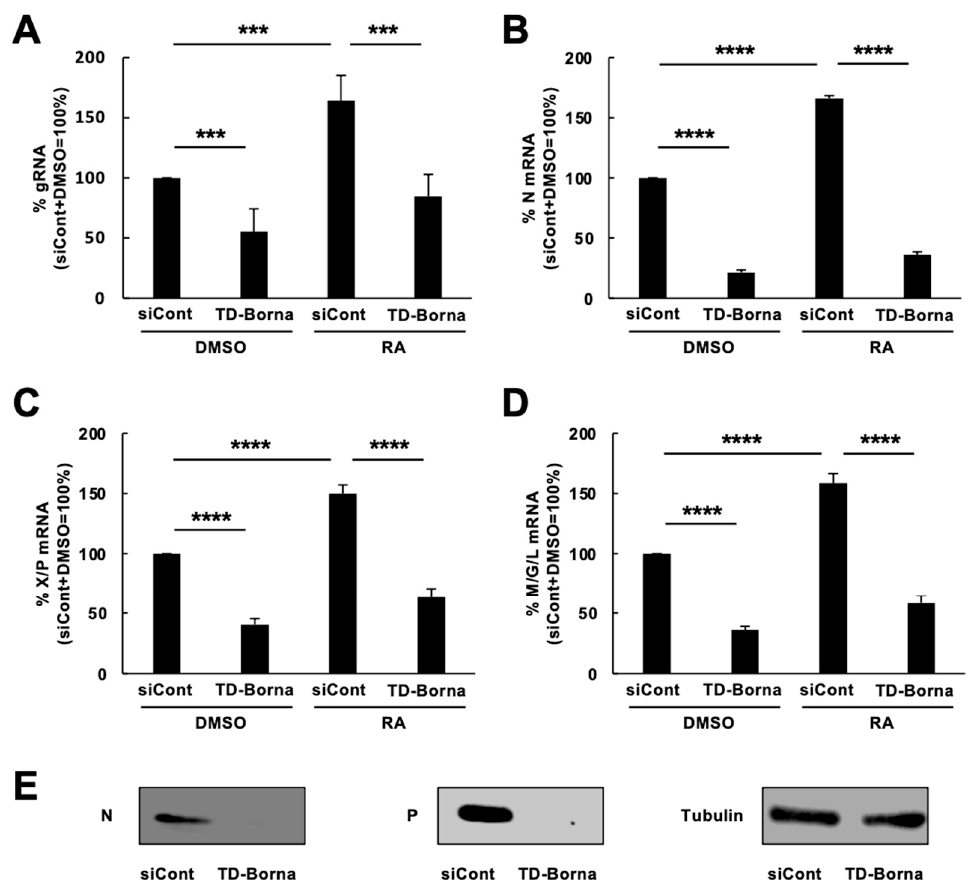
Figure 3. Suppression of BoDV-1 infection by TD-Borna treatment. ( A ) Effects of TD-Borna treatment on BoDV-1 load in SH-SY5Y/BoDV cells. SH-SY5Y/BoDV cells were treated with DMSO or RA in the presence or absence of TD-Borna for 2 days. The amounts of BoDV-1 gRNAs in SH-SY5Y/BoDV cells were determined by RT-qPCR analyses. ( B – D ) The amounts of N ( B ), X/P ( C ), and M/G/L ( D ) mRNAs in SH-SY5Y/BoDV cells. The amounts of BoDV-1 mRNAs were determined by RT-qPCR analyses. ( E ) The amounts of BoDV-1 proteins in SH-SY5Y/BoDV cells. The amounts of BoDV-1 N, BoDV-1 P, and tubulin were determined by western blot analyses using specific antibodies. siCont, the scrambled siRNA-treated control; TD-Borna, the siRNA cocktail against BoDV-1. We calculated the expression of each gene using the ∆∆ Ct method. The expression of each gene was normalized with that of the GAPDH gene in each condition. Values are expressed as the mean percentage + SEM of four independent experiments. ***, p < 0.005; ****, p < 0.001.